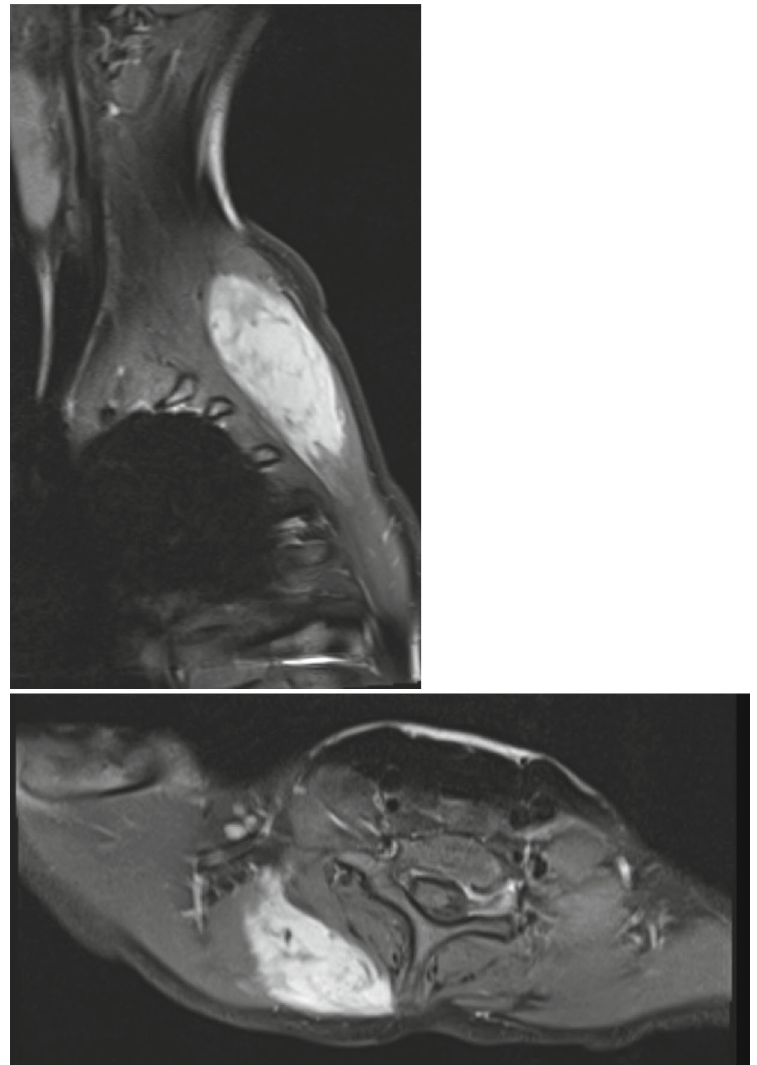
Figure 3: Right parasagittal and axial T1-weighted MRI sections demonstrating gadolinium contrast-enhancing right paraspinal mass consistent with a desmoid